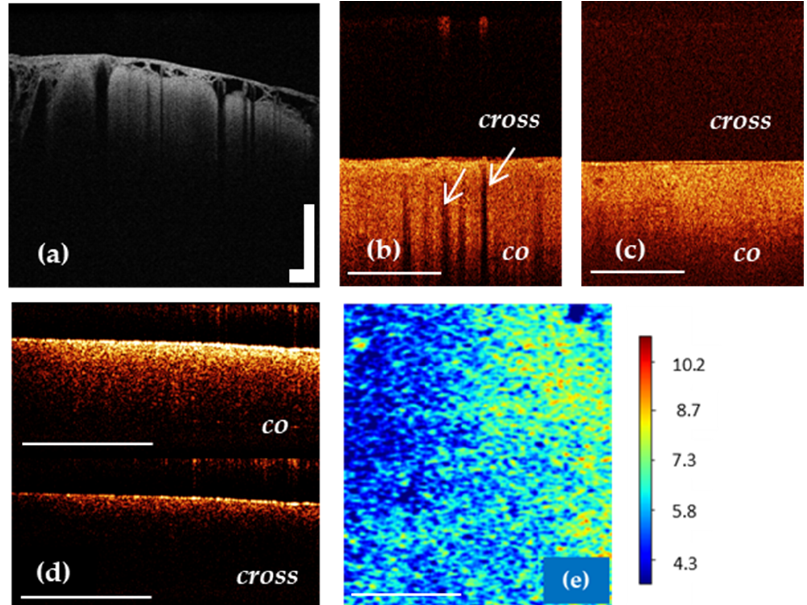
Figure 4. OCT imaging of cortex in vivo ( a , b ) using OCT-integrated microscope and handheld CP OCT probe, ex vivo ( d ) and color-coded OCT map of cortex based on the attenuation coefficient ( e ). The white arrows show a specific vertical striation arising from “shadows” of the blood vessels located just under the cortex surface ( b ), which disappear in the case of tumor infiltration of the cortex ( c ). The CP OCT image includes two parts: co-polarization (co) based on initial state of polarization after backscattering within the tissue and cross-polarization (cross) that determines any orthogonal polarization. Scale bar is 1 mm in all images.